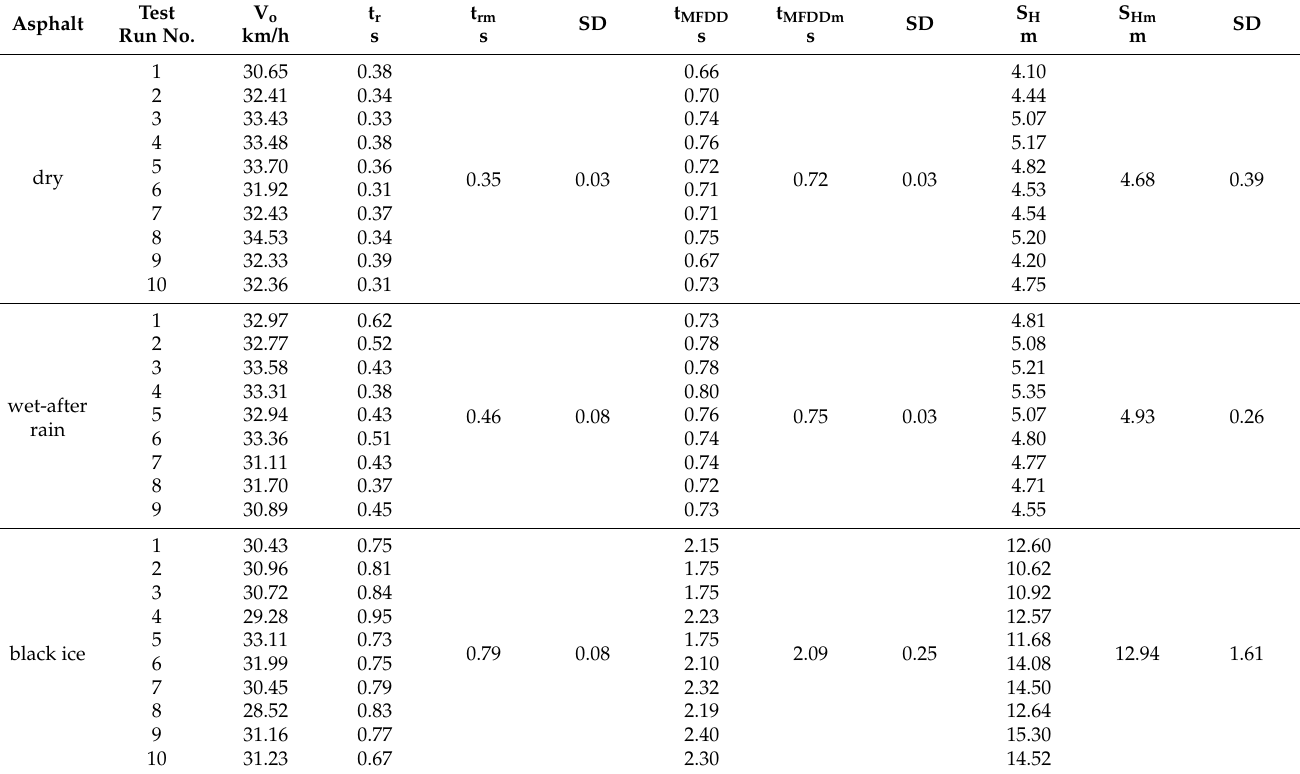
Table 8. The Ford Transit’s deceleration times and braking distances during rapid braking on a dry surface, a wet (after rain) asphalt surface, and a surface covered with a thin ice layer with the initial speed of approximately 30